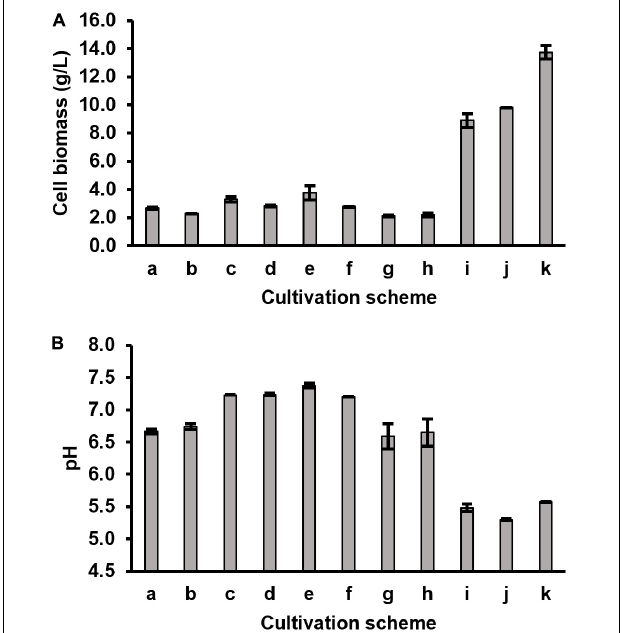
FIGURE 3 | Harvested cell biomass (A) and pH (B) of the spent broth from different cultivation schemes. Two biological replicates for each scheme ( n =